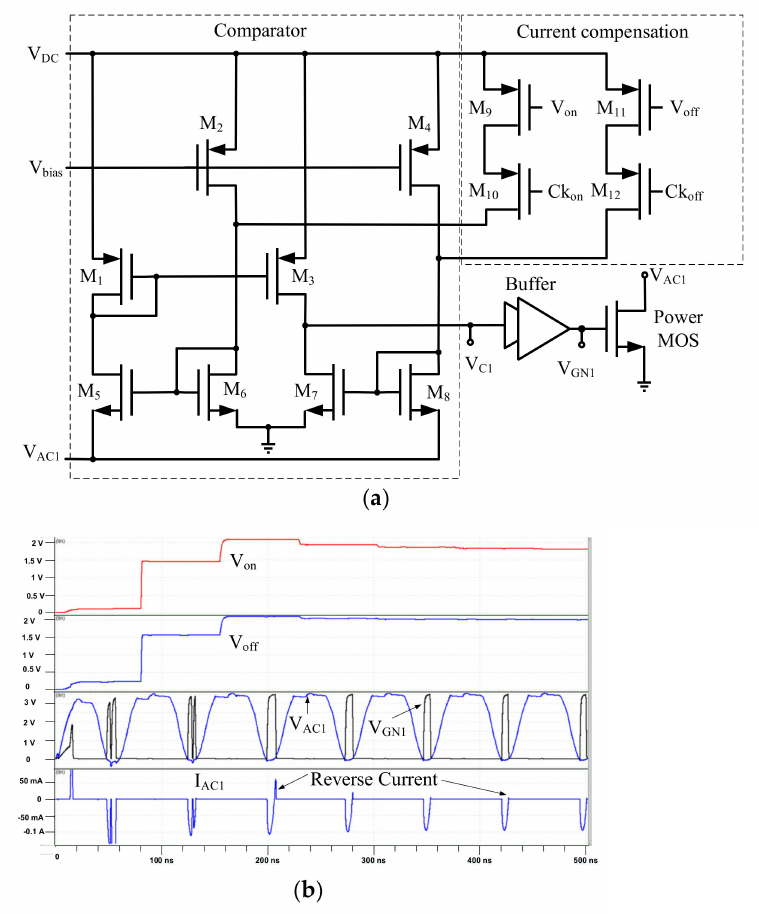
Figure 6. ( a ) Comparator circuit, ( b ) simulation result of V on and V off